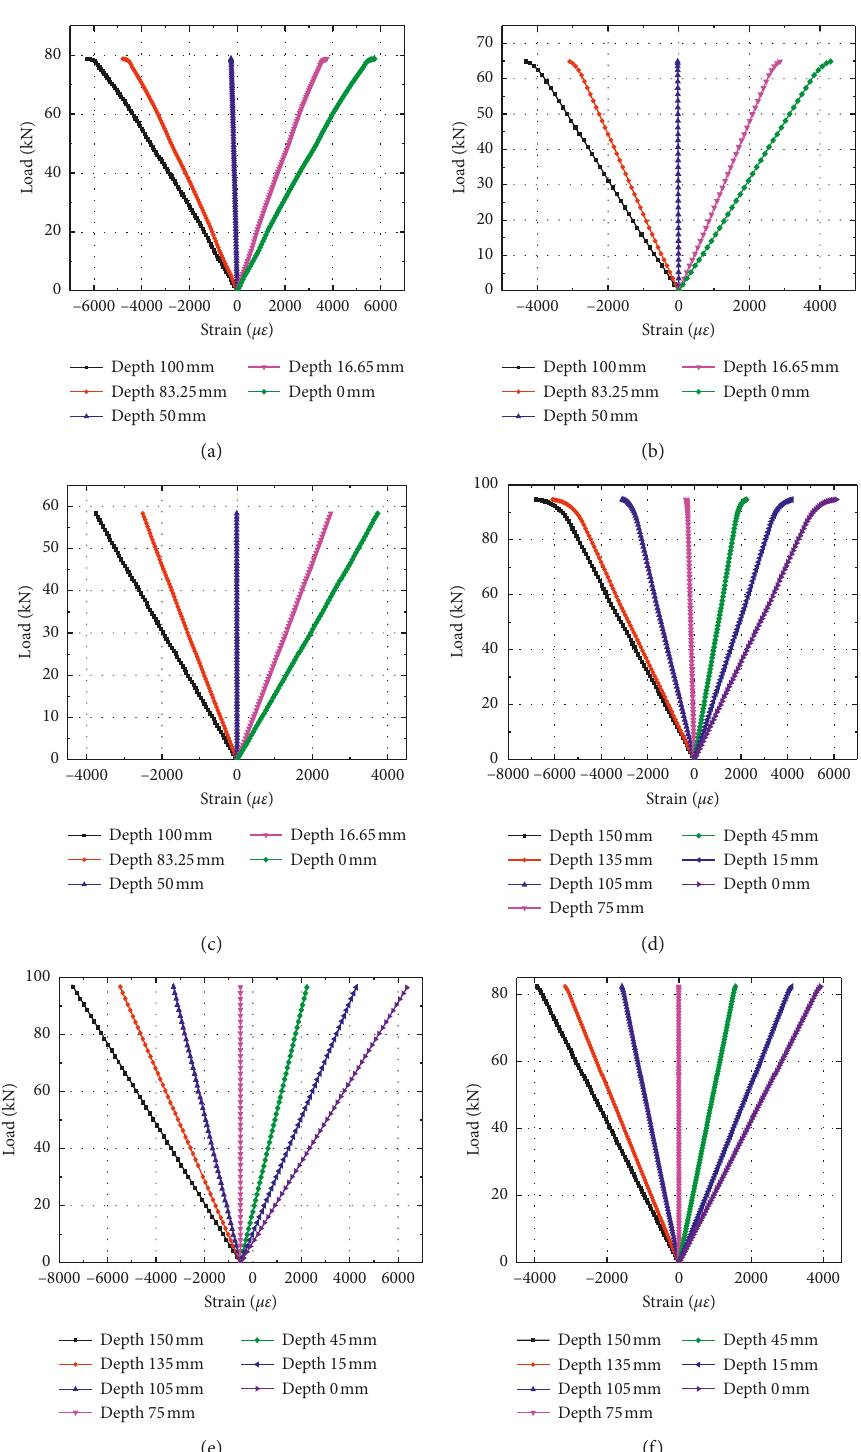
Figure 4: Load-strain curves for cross sections at midspan. (a) Specimen P1. (b) Specimen P2. (c) Specimen P3. (d) Specimen P4. (e) Specimen P5. (f) Specimen